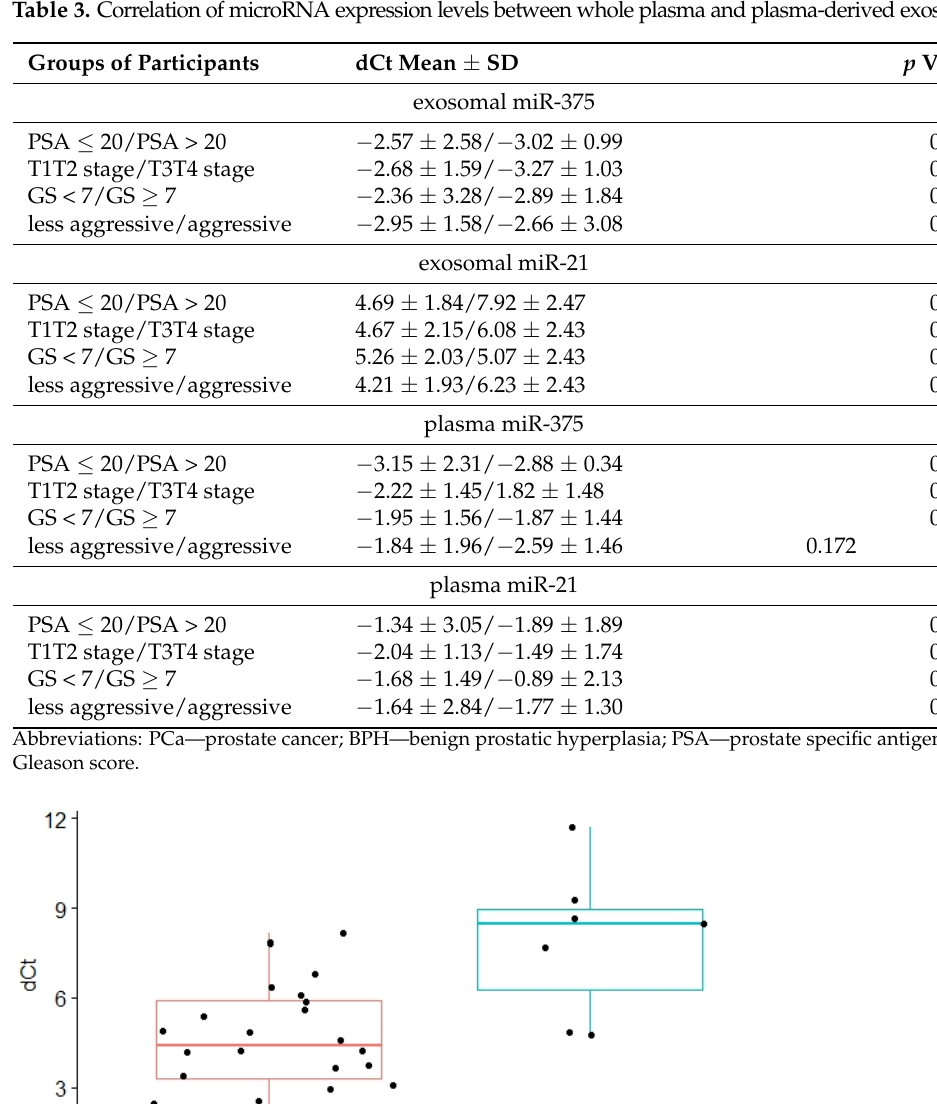
Table 3. Correlation of microRNA expression levels between whole plasma and plasma-derived exosomes.